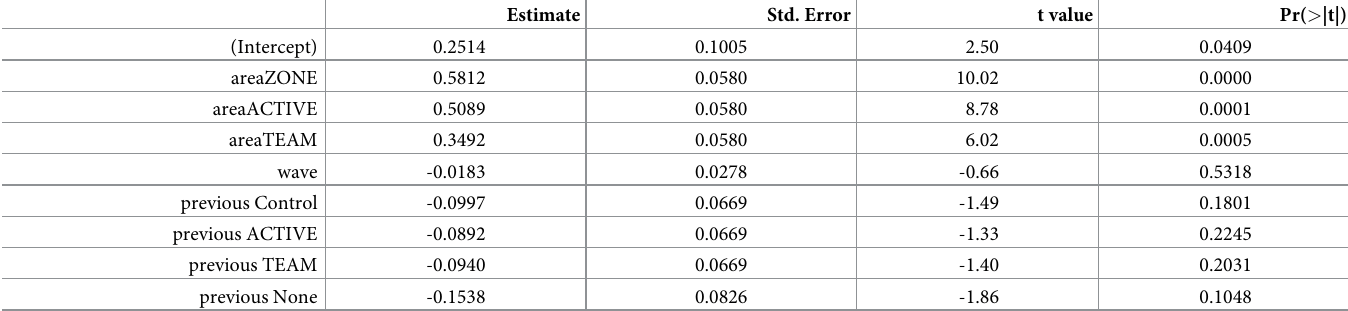
Table 13. GLM results for noise.